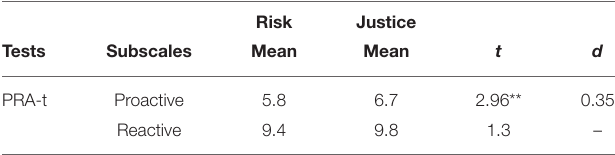
TABLE 6 | Differences in proactive and reactive aggression between the sample of juvenile justice and the sample at risk of social